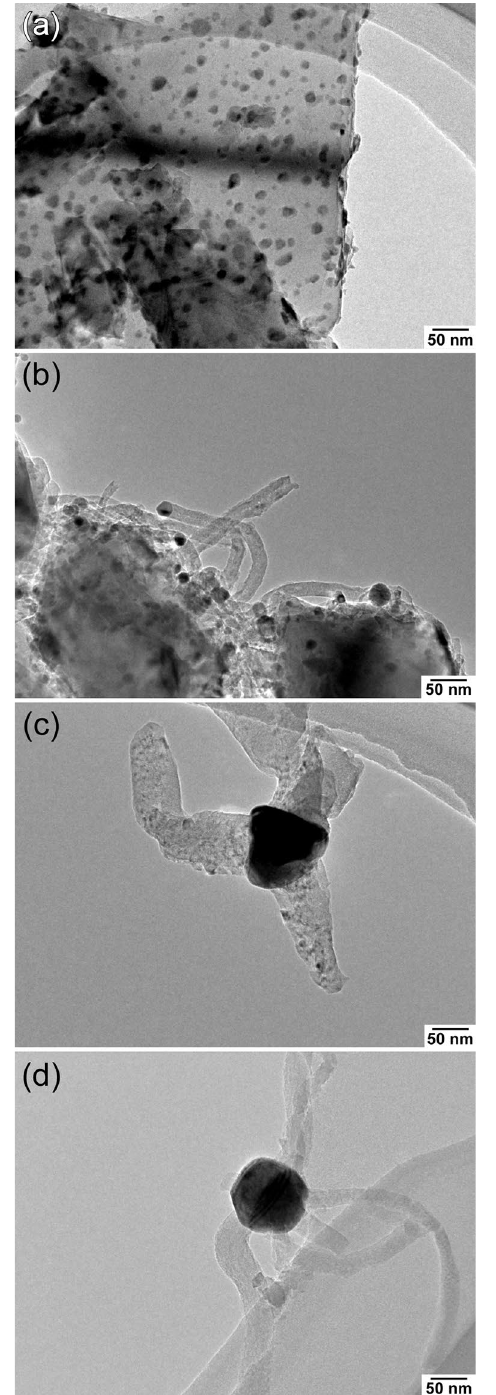
Fig. 8 TEM images obtained from Marimo-like carbon produced at 600 °C using a Ni8Cu2/O-dia. catalyst with reaction times of ( a ) 0 min. (= heating off at the end of Step I, then cooling down in Ar flow), ( b ) 10 min., ( c ) 30 min., and ( d ) 60 min.,